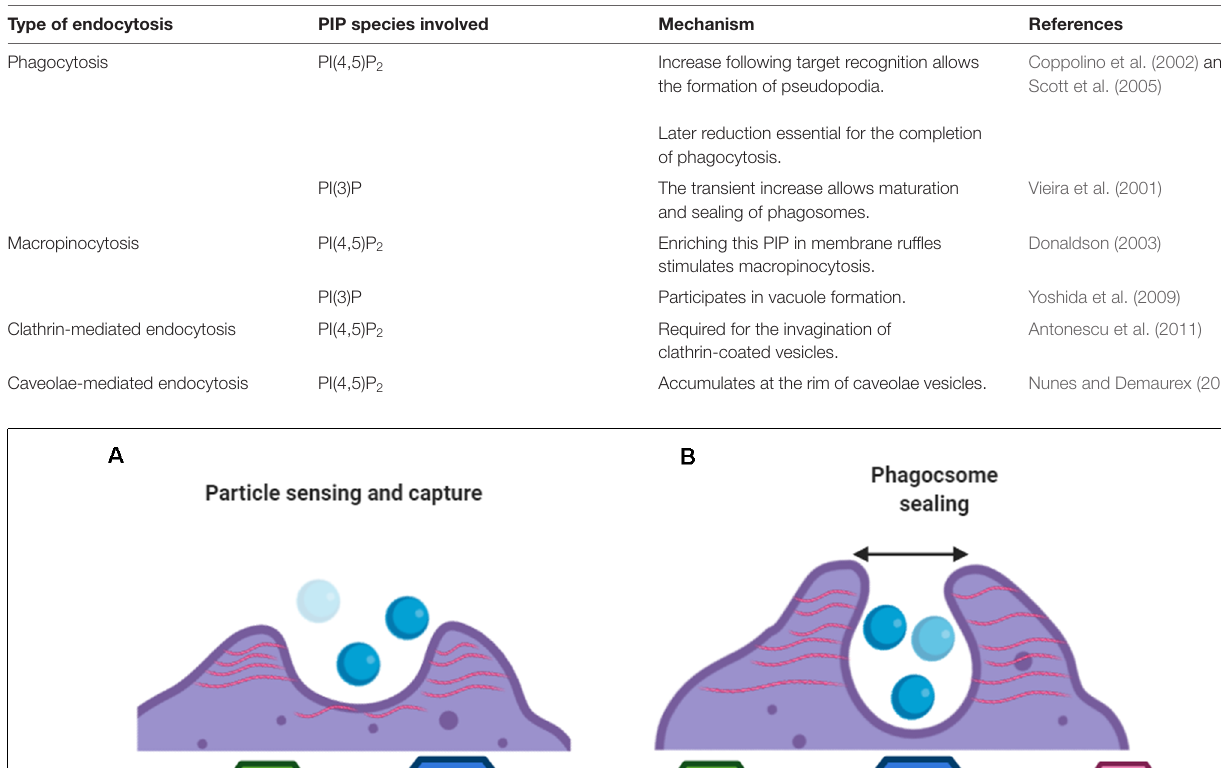
TABLE 3 | Suspected involvement of PIP species in various forms of endocytosis.